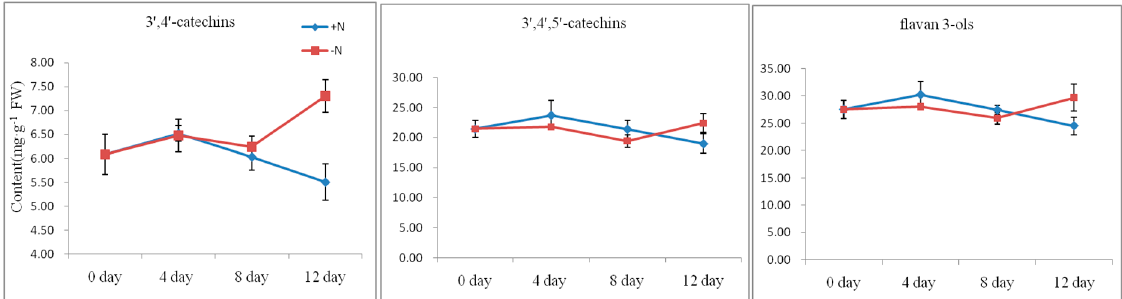
Figure 8. Content of flavan 3-ols in nitrogen deprived tea plants. The data represent the mean ± SD from three independent measurements.